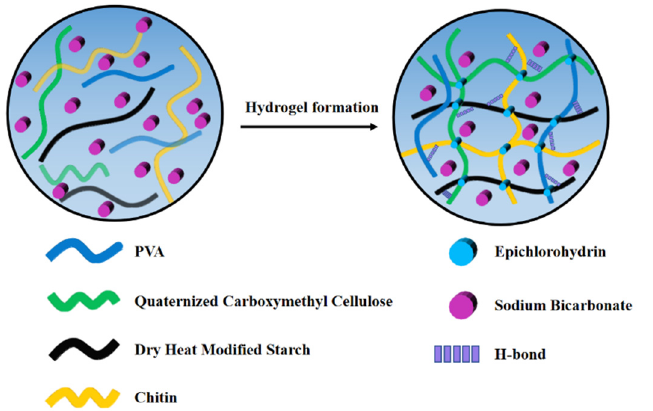
Figure 9. A schematic diagram of the hydrogel formation. Single-factor test: single-factor experiment is used to determine the optimal concentration of dry heat modified starch, quaternized carboxymethyl cellulose, chitin, PVA, epichlorohydrin, sodium bicarbonate. In this test, six concentrations ( w / v % or v/v %) of dry heat modified starch (2.4%, 2.6%, 2.8%, 3.0%, 3.2%), quaternized carboxymethyl cellulose (0.48%, 0.64%, 0.8%, 0.96%, 1.12%), chitin (0.4%, 0.6%, 0.8%, 1.0%, 1.2%), PVA (0.6%, 0.8%, 1.0%, 1.2%, 1.4%), epichlorohydrin (3.6%, 4.8%, 6%, 7.2%, 8.4%) and sodium bicarbonate (0.4%, 0.6%, 0.8%, 1.0%, 1.2%) were selected to perform single-factor test. The swelling properties